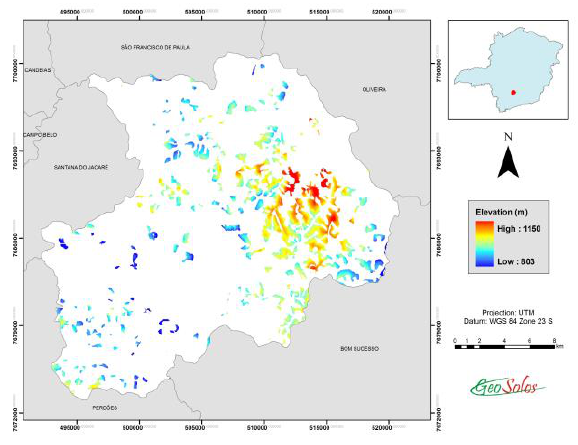
Figure 1. Elevation (m) of coffee fields of Santo Antonio do Amparo, Minas Gerais, Brazil.